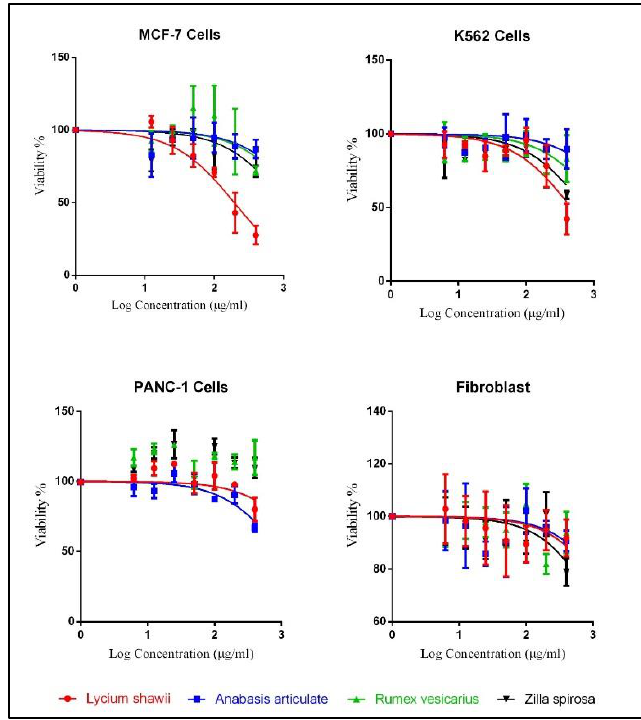
Figure 3. The log dose-response curve of cancer cell lines compared to the fibroblasts. Values are represented as mean ± SD.